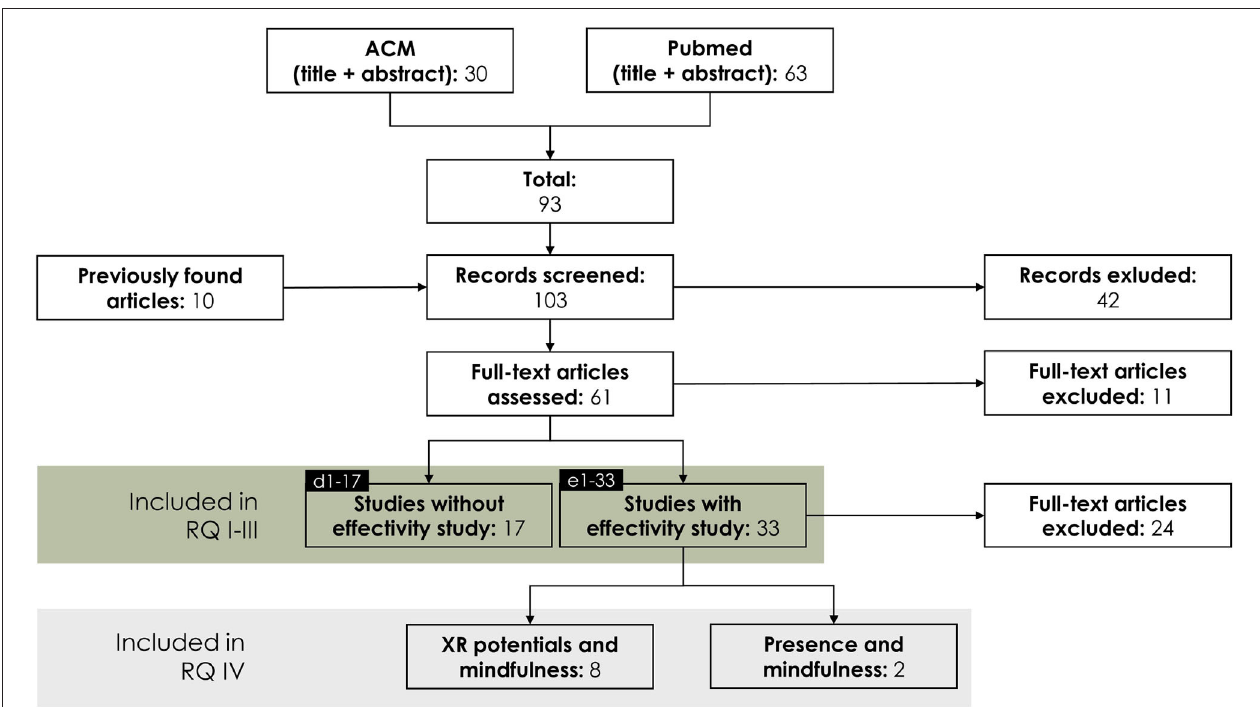
FIGURE 1 | Depiction of the PRISMA flow diagram (Moher et al., 2011). The chart shows the process of paper extraction. Fifty papers were included in the analysis of XR-based mindfulness support. Ten papers were included in the final effect